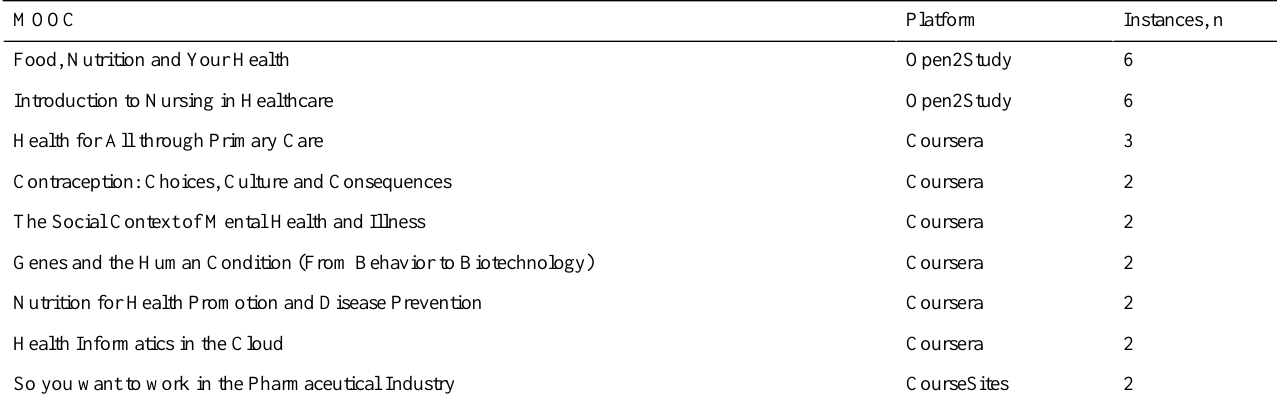
Table 6. MOOCs offered multiple